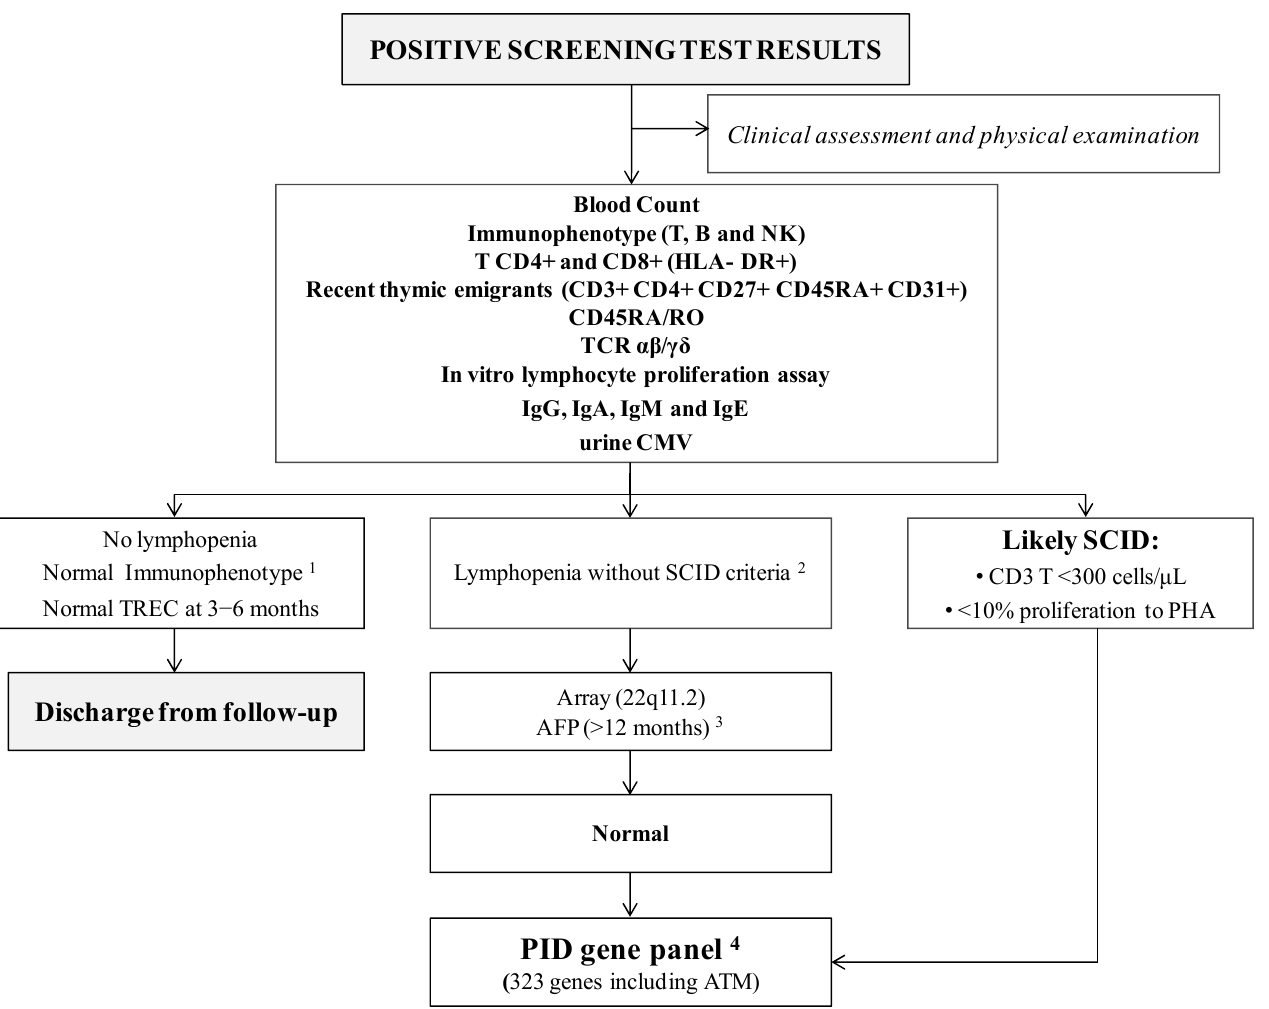
Figure 2. Immunological and genetic protocol in positive cases. 1 Flow cytometry protocols are shown in [5]; 2 Lymphopenia and SCID criteria are shown in [5]; 3 AFP values are not reliable before 12 months of age; therefore, AFP was only studied in patients older than one year lacking an alternative diagnosis; 4 The list of 323 PID genes is shown in [5]. Abbreviations: AFP, alpha-fetoprotein; ATM, ataxia telangiectasia; B, B-cells; CMV, cytomegalovirus; Ig, immunoglobulin; NK, natural killer cells; PID, Primary immunodeficiency; SCID, severe combined immunodeficiency; T, T-cells; TCR, T-cell receptor; TRECs, T-cell receptor excision circles.